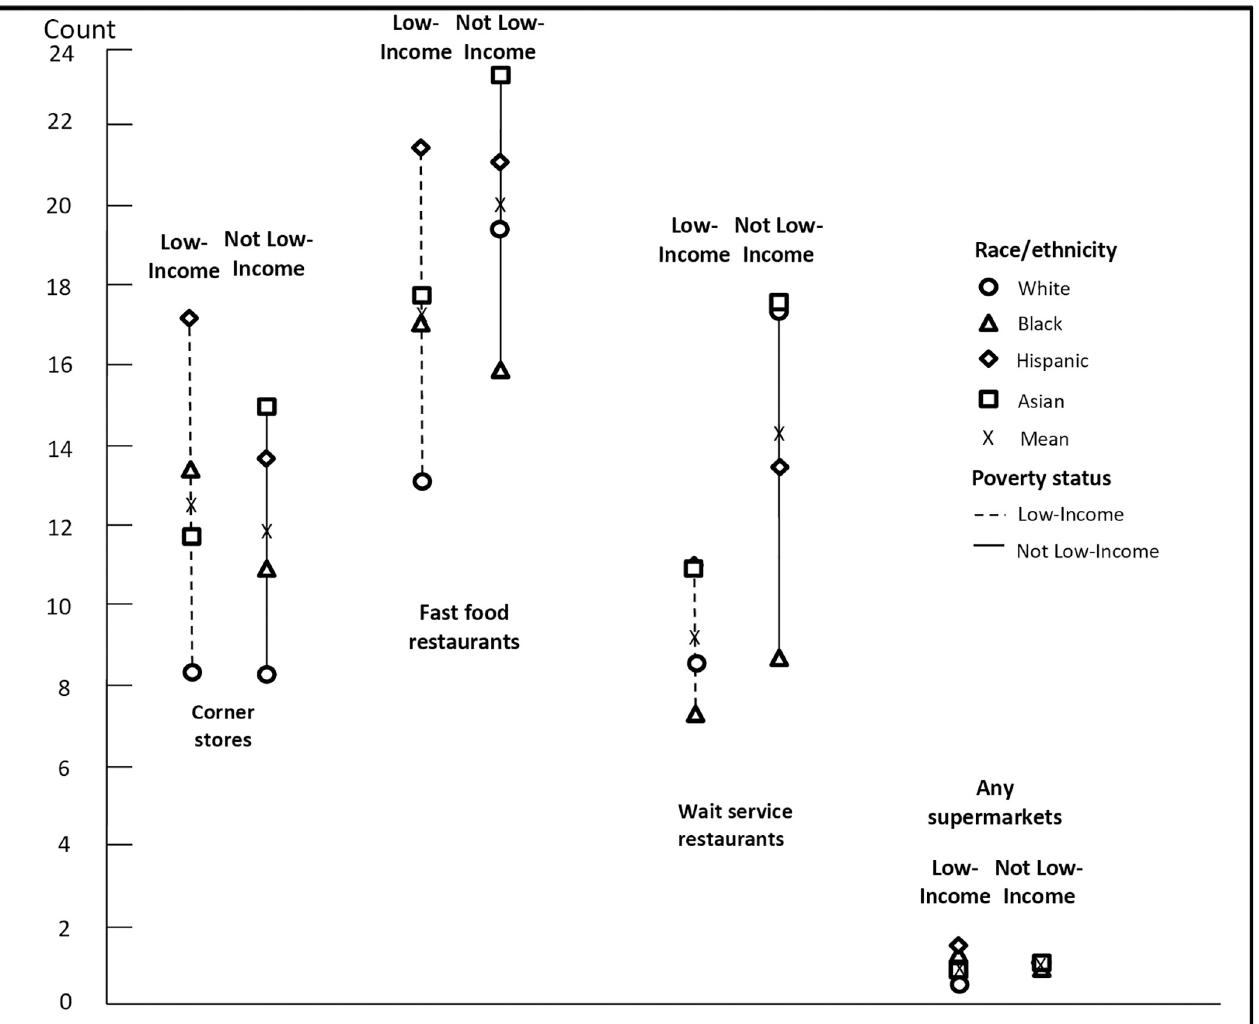
Fig 5. Mean count within 0.25 miles (1,320 ft) of food facilities from school, race and poverty interactions, 2013. We conducted joint F-test with school level clustered errors suggests significant differences among income and race groups (p < 0.05). And pair-wise T-tests for multiple comparisons based on Bonferroni correction (28 pairs in total, with each pair tested on all four food outlets, separately). More often than not, the T-test indicated no statistically significant difference. S21 Table presents test results (p-values) for each pair.